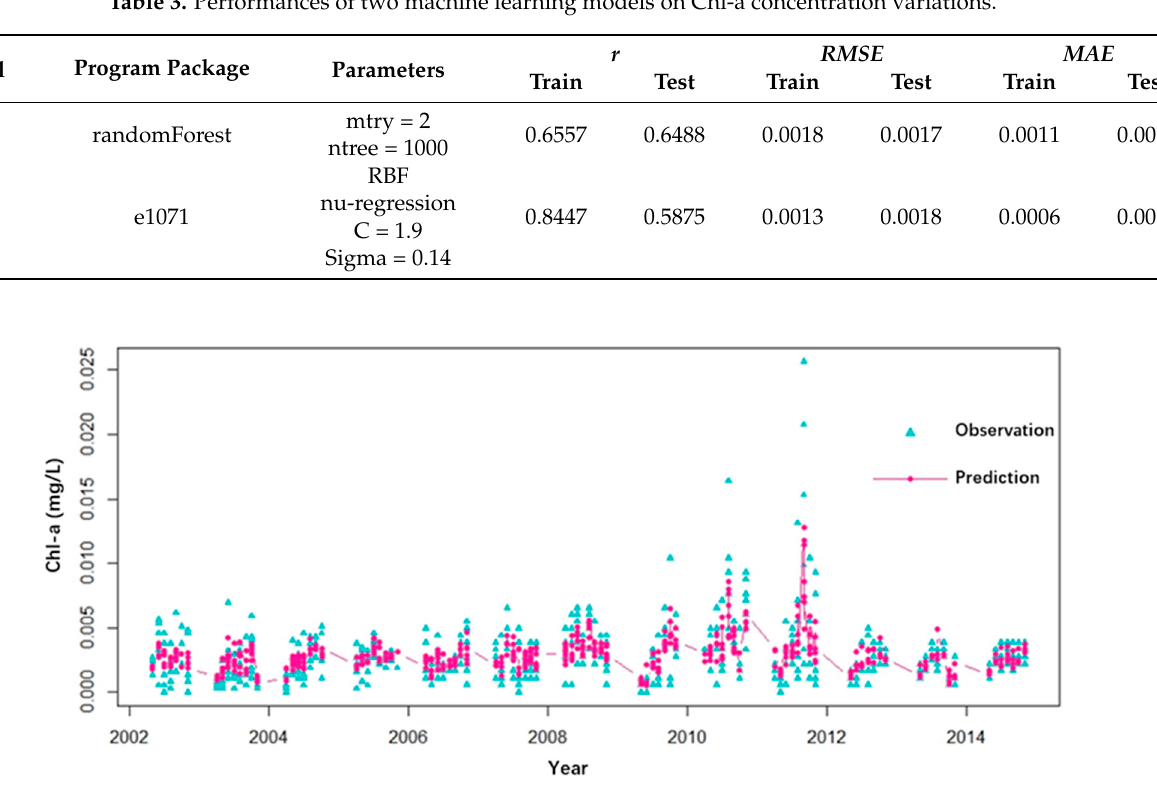
Figure 5. Prediction results of RF model in test stage. Figure 6. Prediction results of SVM model in train stage.